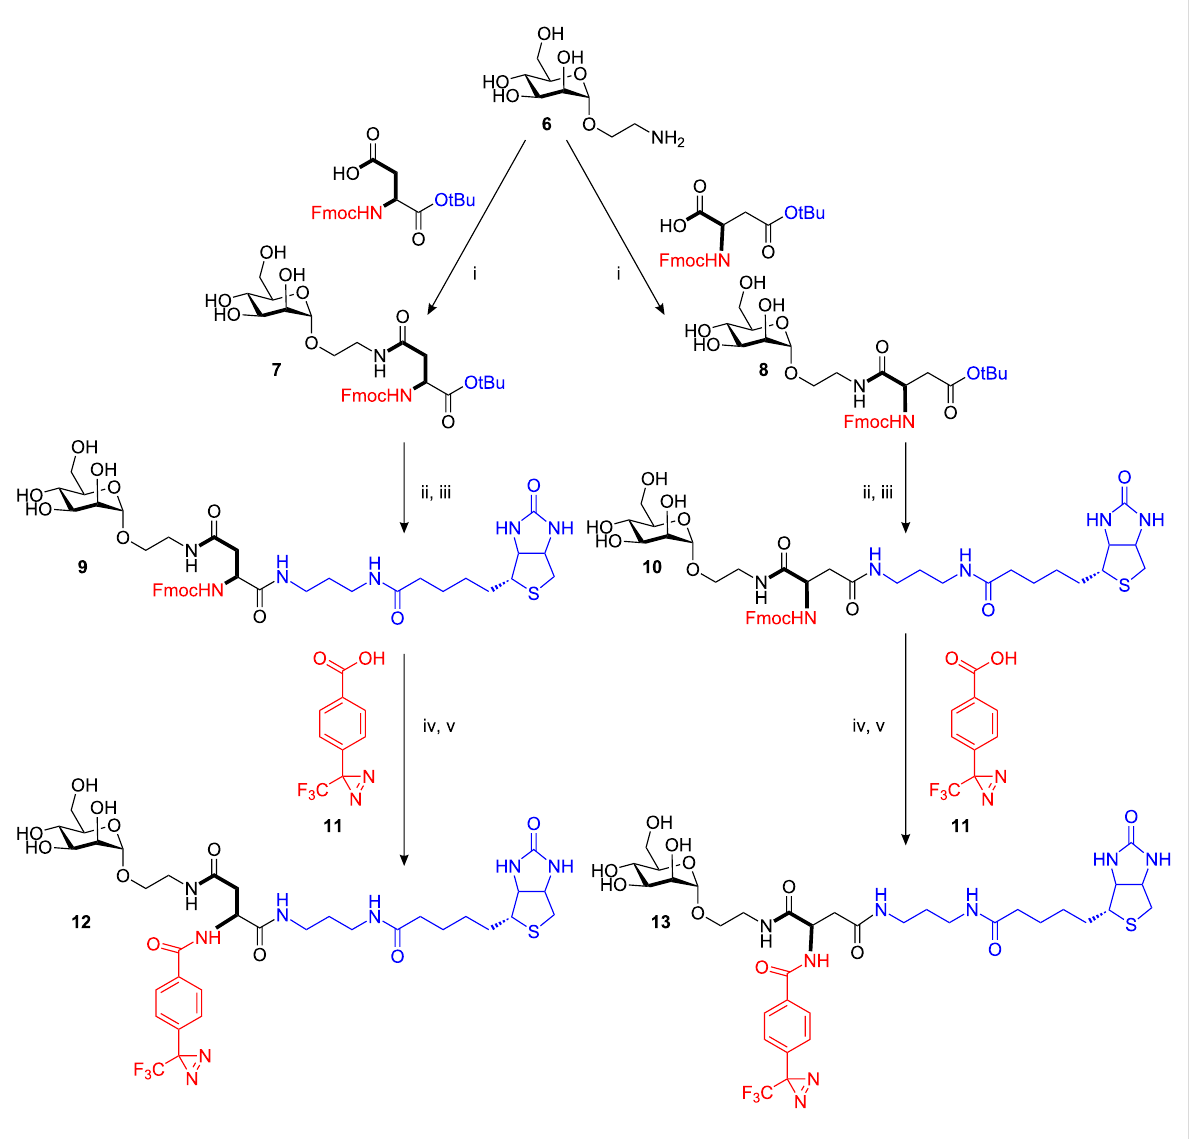
Scheme 1: Synthesis of photoactive glycoamino acids 11 and 12 . i) Fmoc-Asp-O t Bu (for 7 ), Fmoc-Asp(O t Bu)-OH (for 8 ), HATU, DIPEA, dry DMF, N 2 , RT, 95% for 7 and 96% for 8 ; ii) 80% aq TFA, RT; iii) (+)-biotinylamidopropylammonium trifluoroacetate, HATU, DIPEA, dry DMF, N 2 , RT, 48% (two steps) for 9 and 26% (two steps) for 10 ; (iv) 20% piperidine, dry DMF, RT; v) HATU, DIPEA, dry DMF, Ar, RT, 81% (two steps) for 12 and 98% (two steps) for 13